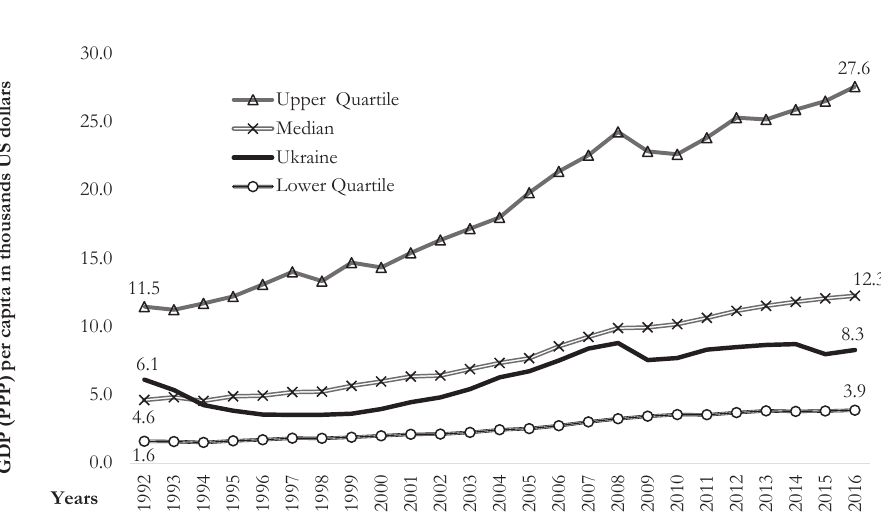
Fig. 2 – Quartiles of GDP (PPP) per capita in the world in 1992-2016 (in thousand US dollars). Source: own calculations based on the data from International Monetary Fund World Economic Outlook In 1992, relatively sustainable patterns of economic growth of all countries were formed in the world but their growth rates are fundamentally different. 25% of the poorest countries could increase the value of GDP per capita from $1,6 thousand to a maximum level – $3,9 thousand. The annual average absolute growth of this indicator was $96. At the same time, 25% of the richest countries were able to reach the average annual growth of almost $671. Exceeding by 7 times of growth rates in developed economies shows that the innovation economies are rapidly ahead other countries.